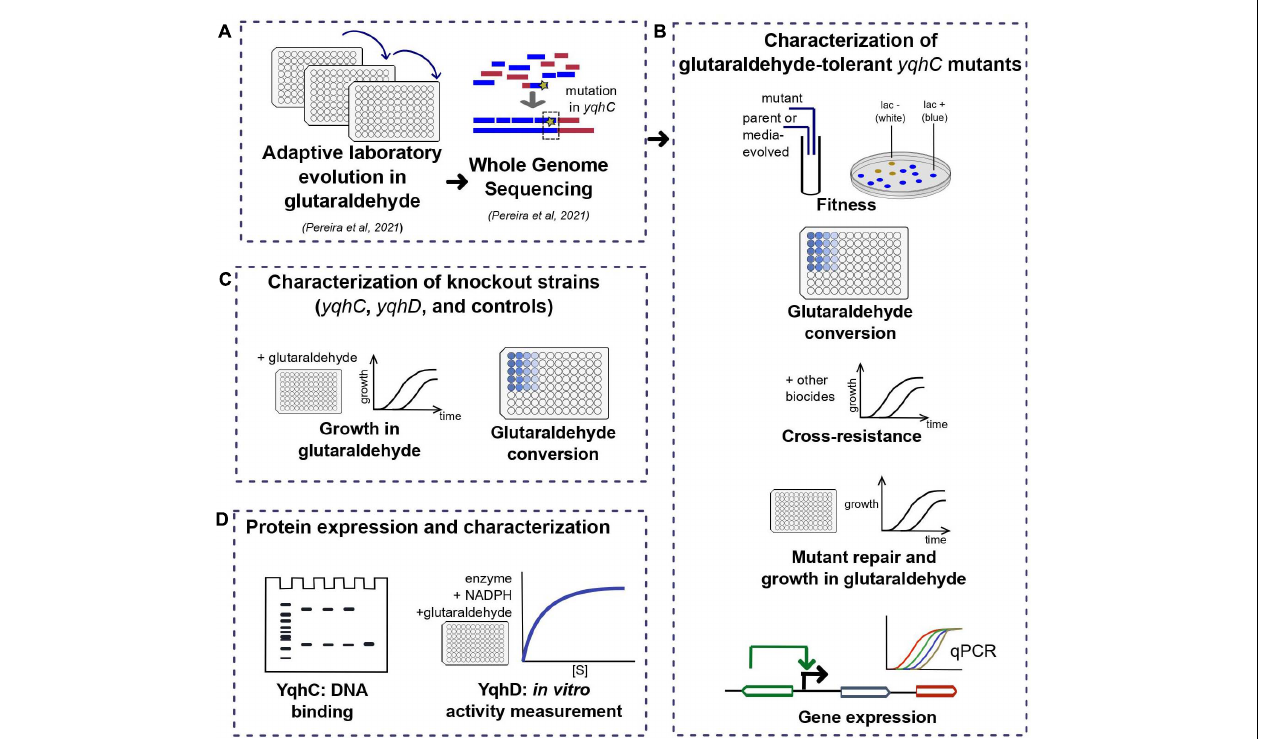
FIGURE 1 | Workflow for the investigation of the E. coli tolerance mechanism to glutaraldehyde. In short, (A) we have previously detected three tolerant strains after ALE (Pereira et al., 2021) with mutations in different locations of yqhC . In this work, we (B) characterized the tolerant strains in terms of fitness, growth in glutaraldehyde, cross-resistance to other biocides, expression of yqhC and the regulated genes yqhD and dkgA and glutaraldehyde conversion. To identify the gene responsible for the tolerance phenotype, we (C) checked the growth in glutaraldehyde of knockout strains of each gene and various controls and investigated the differences in conversion of glutaraldehyde between mutants, parental strains and knockout strains. Lastly, we isolated the proteins of interest (D) and tested for binding to DNA (YqhC) and glutaraldehyde conversion